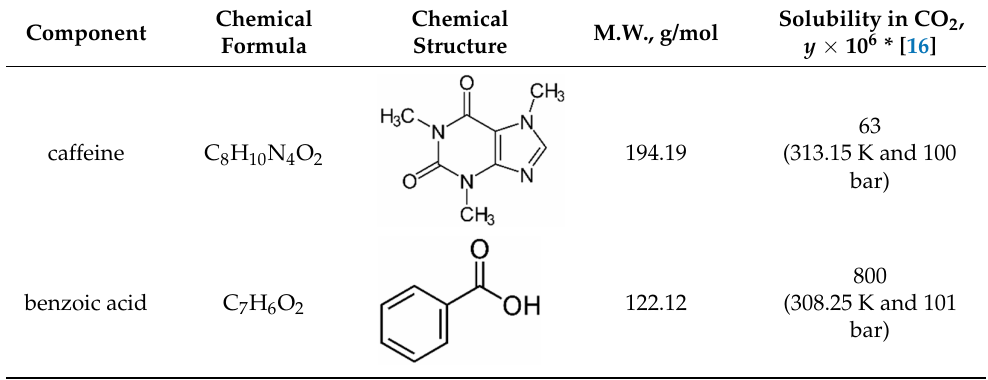
Table 1. Chemicalstructuresandbasicphysicochemicaldata(e.g., molecularmass)ofthemodelcompounds. Chemical Chemical Component Formula